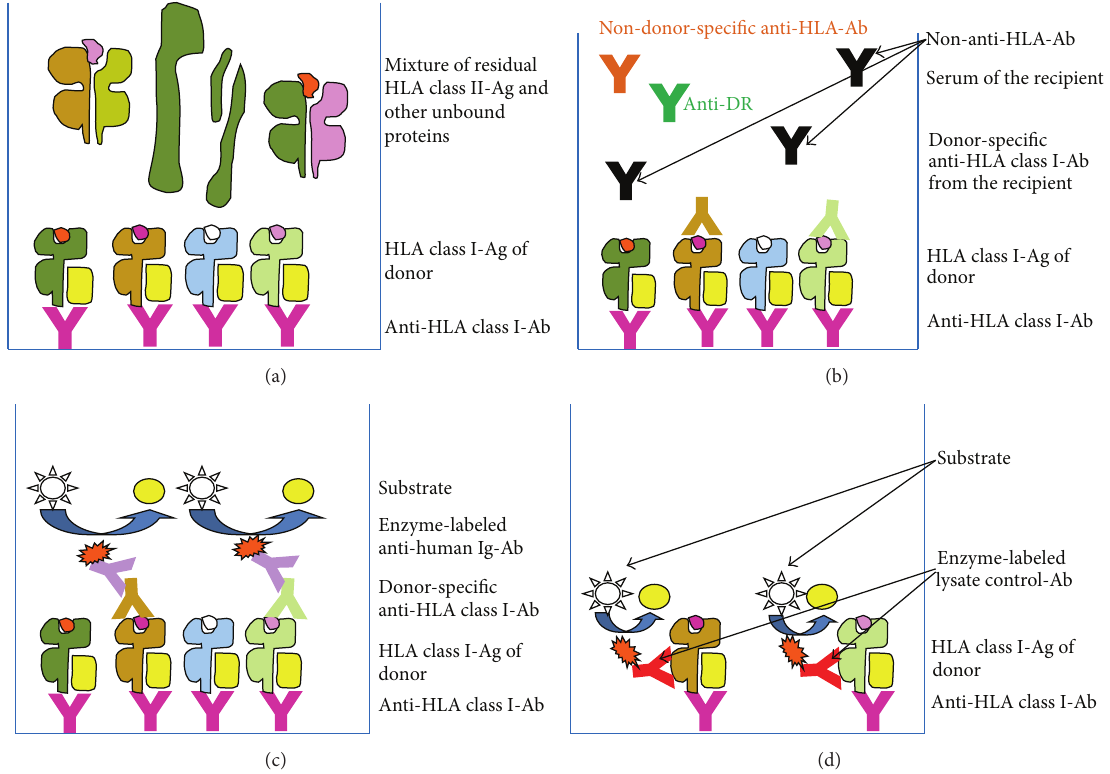
Figure 1: Flow diagram of the AMS-ELISA shown for the detection of HLA class I molecules. (a) Binding of the donor’s solubilized HLA class I molecules by monoclonal capture antibodies recognizing a monomorphic epitope on HLA class I molecules. (b) Binding of the donor-specific anti-HLA antibodies out of the recipient’s serum to the HLA molecules of the donor. (c) Binding of alkaline phosphatase conjugated secondary antibodies to the recipient’s bound donor-specific anti-HLA class I antibodies and subsequent color reaction. The original protocol was modified by substituting the human IgG-specific antibody by a human IgG/M/A-specific secondary antibody. (d) Lysate control using an alkaline phosphatase conjugated monoclonal detection antibody directed against a second monomorphic epitope to confirm the immobilization of a sufficient amount of HLA molecules by the solid-phase-bound capture antibody. The AMS-ELISA variant for the identification of donor-specific antibodies directed against HLA class II molecules is correspondingly